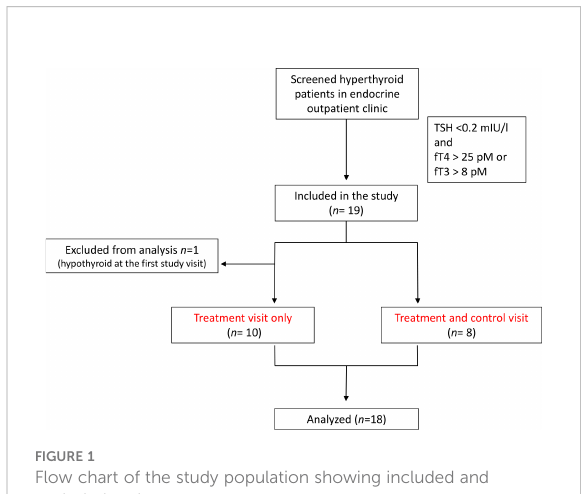
FIGURE 1 Flow chart of the study population showing included and excluded